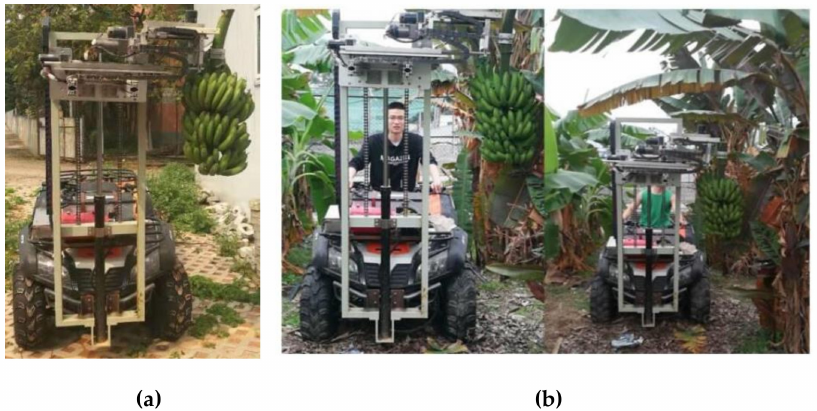
Figure 4. Banana picking machine for flat terrain banana orchard: ( a ) prototype of the banana picking machine; and ( b ) picking banana bunches in an orchard of Zhanjiang City, Guangdong Province,